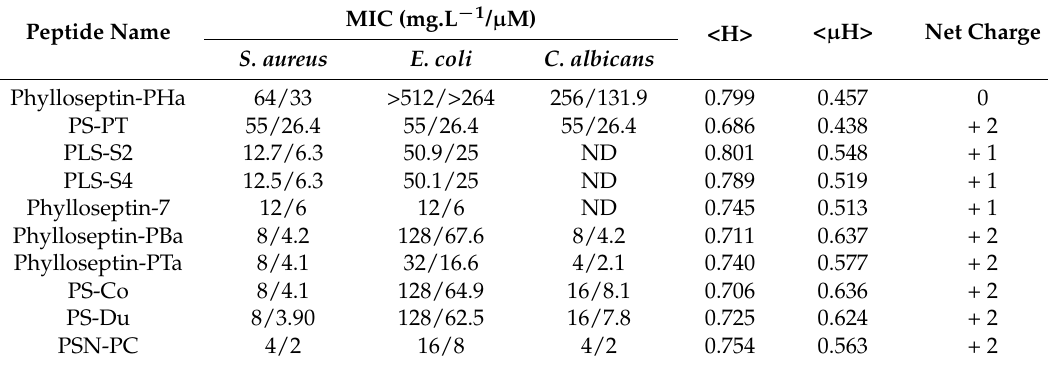
Table 2. Minimum inhibitory concentrations (MICs) and corresponding physicochemical parameters of natural phylloseptin AMPs against specified microorganisms.